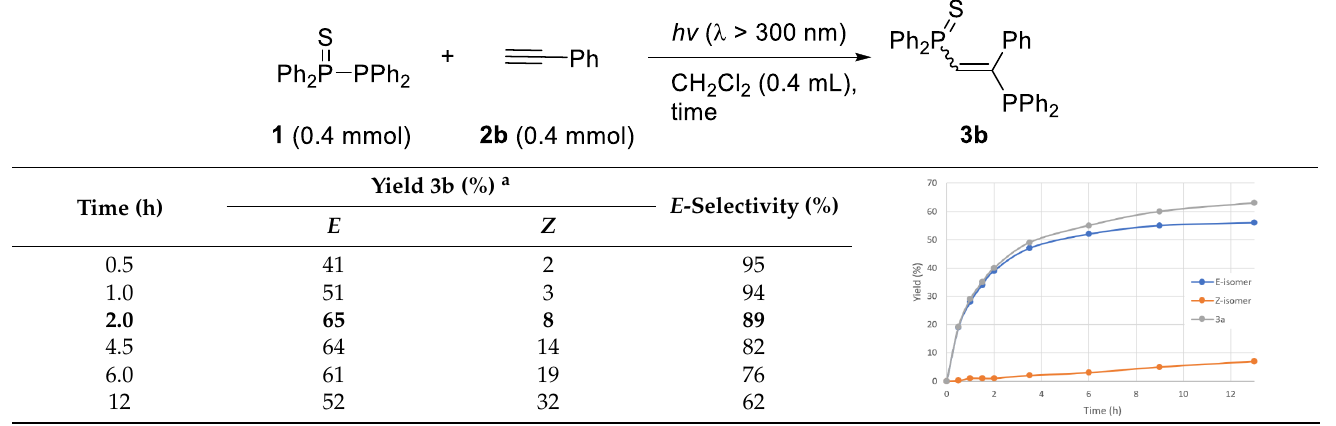
Table 2. Time-dependent profiles of the bisphosphination of phenylacetylene 2b